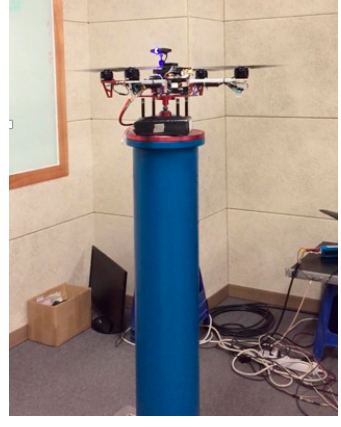
Figure 2. DJI F450 quadcopter.